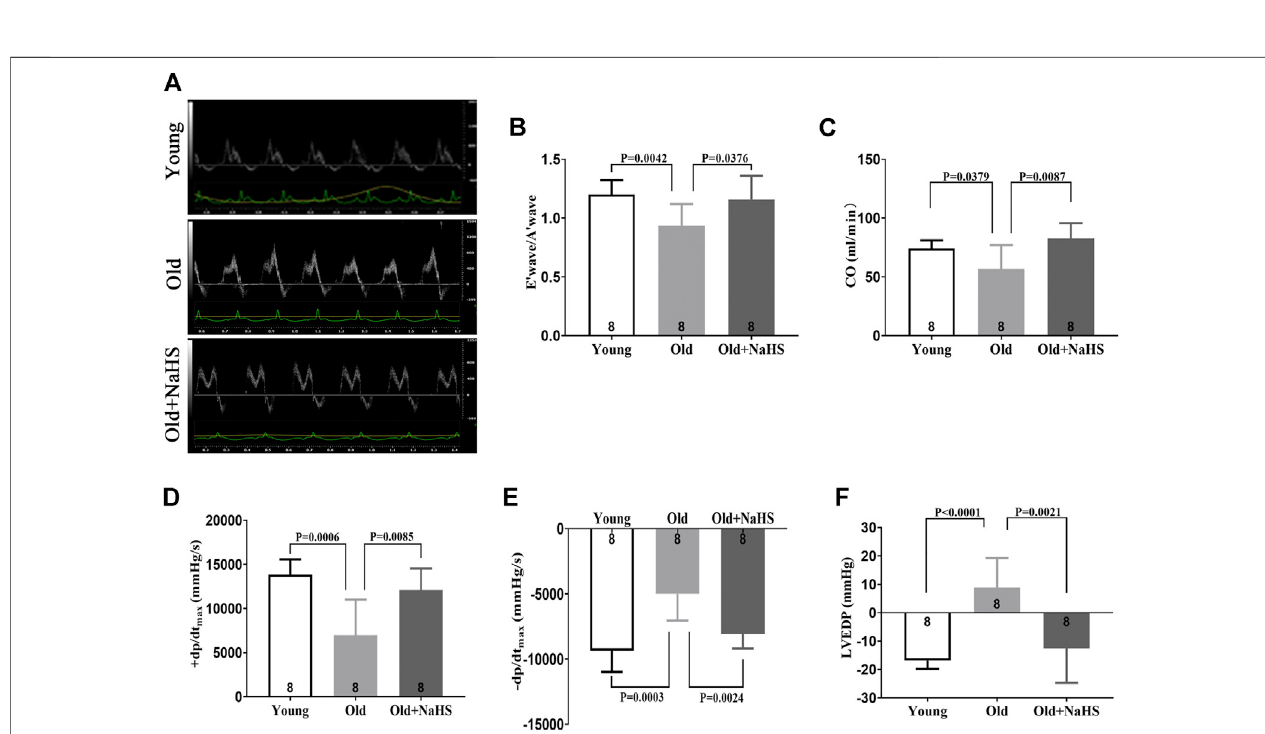
FIGURE4| H 2 Simprovedcardiac functioninagingrats. (A) RepresentativeimagesofthePWDoppler-modebyechocardiographyindicatedE ′ waveandA ′ wave inagingrats. (B) E ′ wave/A ′ waveratiosinagingrats. (C) ValuesofCOinagingrats. (D) Valuesof+dp/dt max inagingrats. (E) Valuesof − dp/dt max inagingrats. (F) Values of LVEDP in aging rats. Results are means ± SEM. A p -value of < 0.05 was considered signi fi cant. +dp/dtmax: the maximum rate of left ventricular pressure rise. − dp/ dtmax: the maximum rate of left ventricular pressure fall. LVEDP: left ventricular end diastolic pressure.